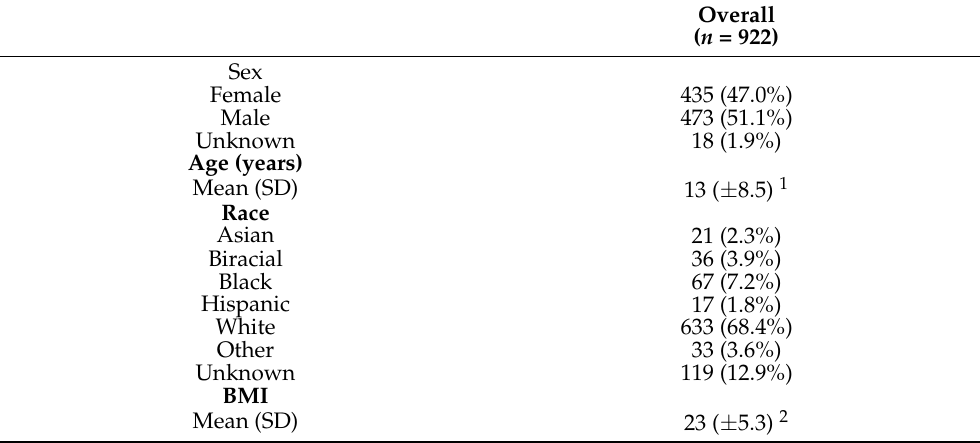
Table 1. Patient Demographics.